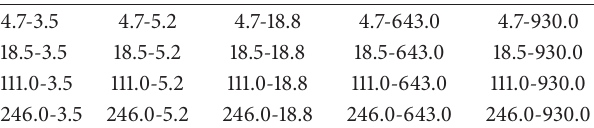
Table 2: Expected Tg and TgAb concentrations of twenty experi- mental samples produced with patient serums. Values are expressed as Tg (ng/mL)-TgAb